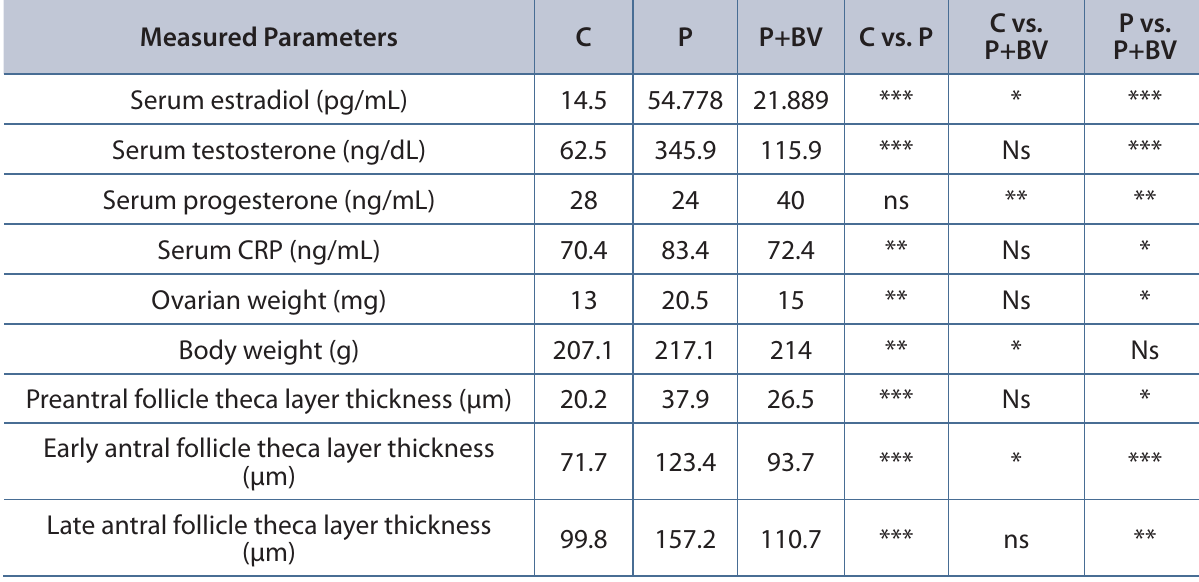
Table 1. Bee venom treatment effects in polycystic ovarian syndrome (PCOS). Baseline parameters of PCOS rats (n = 10) and controls (n = 10) and bee venom-treated rats (n = 10) Measured